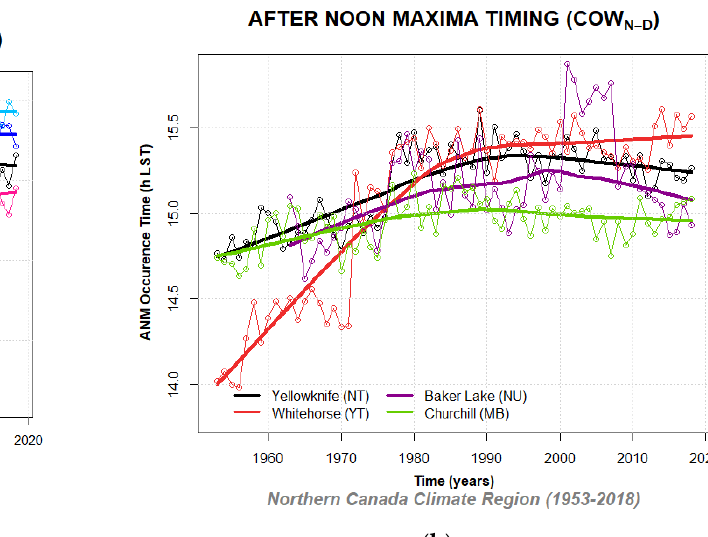
Figure A28. Annually averaged After Midnight Minima ( a ) and After Noon Maxima timing shifts ( b ) and LOESS fit curves for Yellowknife (NT), Whitehorse (YT), Baker Lake (NU), and Churchill (MB) temperature time series, from Northern Canada, including North British Columbia Mountains/Yukon, Mackenzie District, Arctic Tundra, and part of Northeastern Forest climate region.